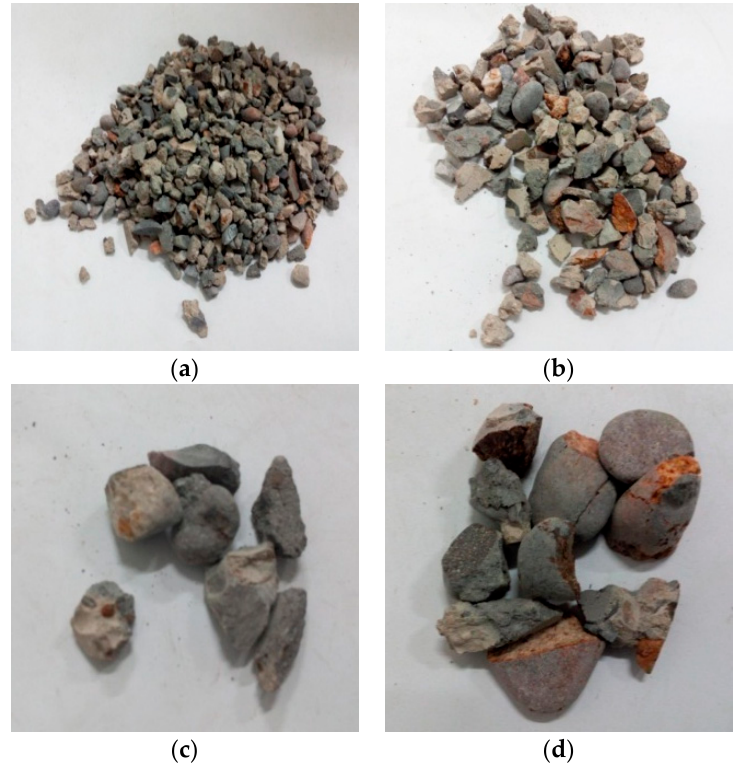
Figure 11. Concrete particles after rapid heating up to 600 °C and sieving (impact speed 8.6 m/s), water cooling. ( a ) 5 mm (53.26%); ( b ) 10 mm (33.59%); ( c ) 16 mm (5.26%); ( d ) 20 mm (7.71%).